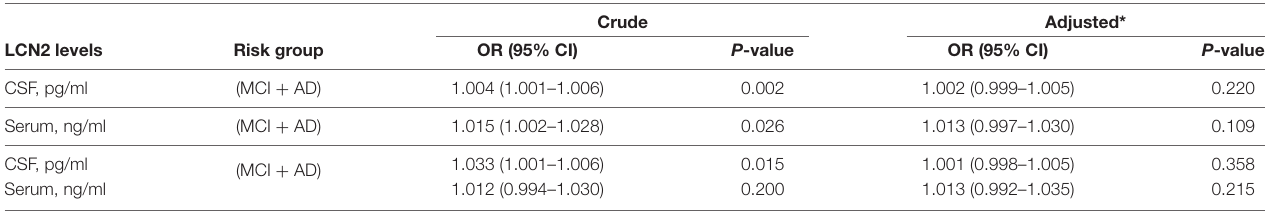
TABLE 2 | Crude and adjusted OR with 95% CI from binary logistic regression for the probability of having cognitive impairment (AD + MCI) using SCC as reference group for the Swedish groups.